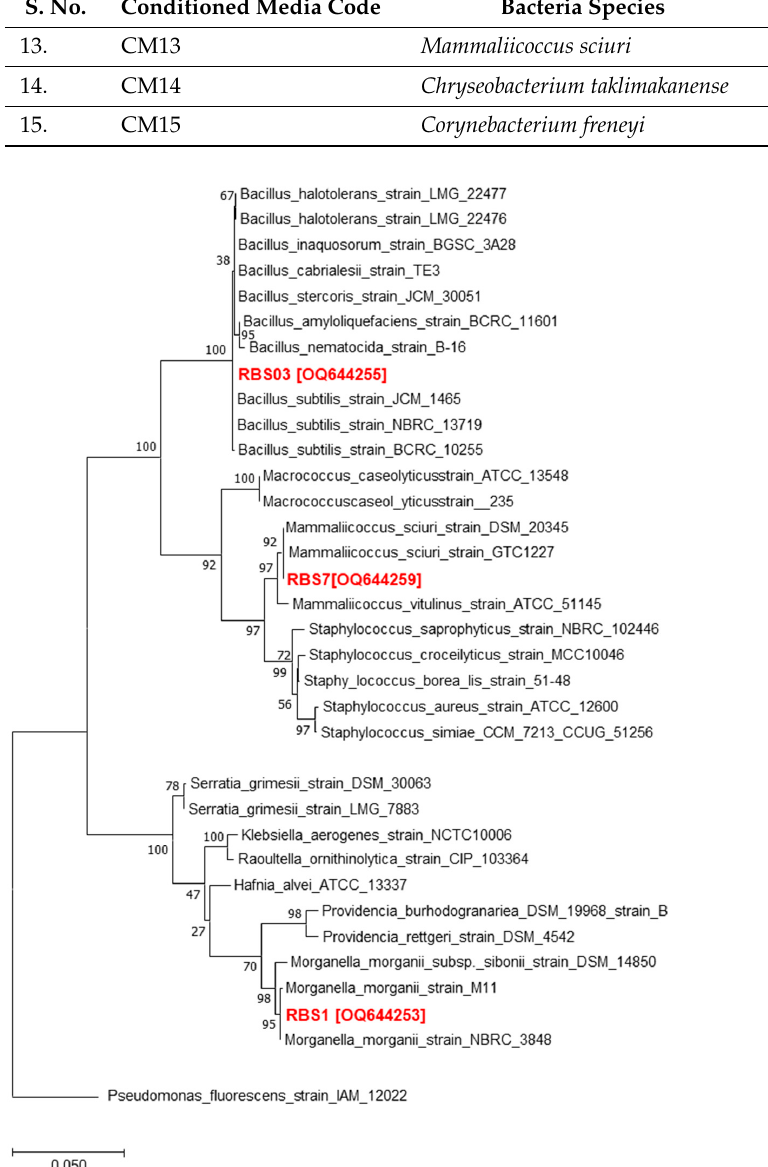
Figure 1. Based on the phylogenetic analysis of their 16 S rRNA genes, the phylogenetic tree shows the isolated bacteria from the water monitor lizard stomach that were employed in this work (red) and Pseudomonas fluorescens as an outgroup. The GTR+G model with concatenated 16 S rRNA sequences was used as the foundation for the dendrogram reconstruction using the Maximum Likelihood (ML) approach (MEGA 7). Branching nodes show percentage bootstrap values higher than 50% of 1000 repetitions.